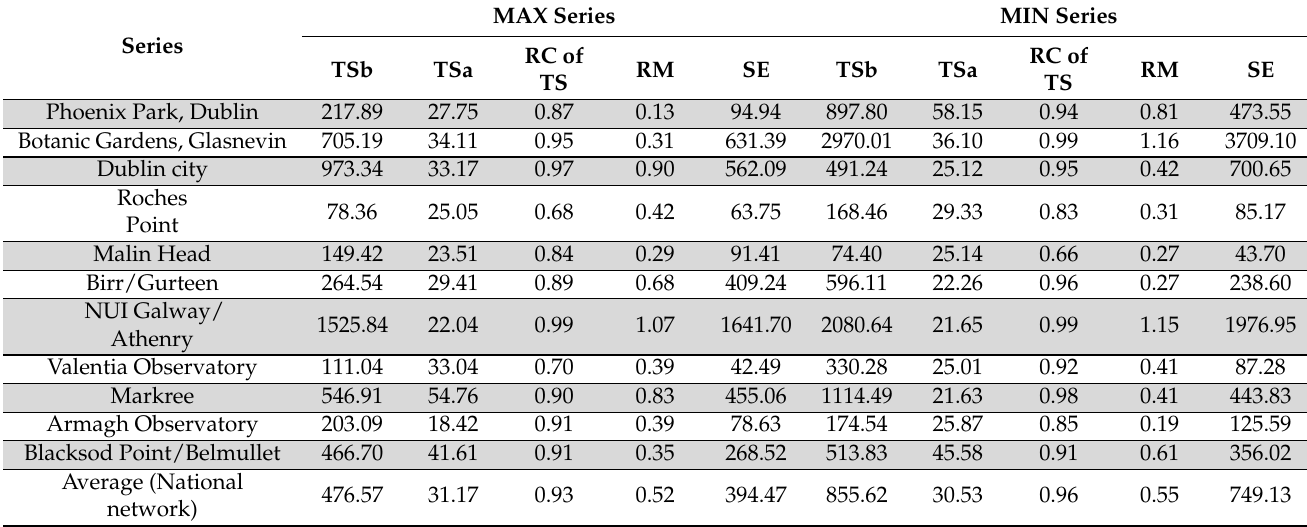
Table 7. Average test statistics for series included in the national network. Critical value (significance level 0.05): 21.94. TSb—test statistics before homogenisation; TSa—test statistics after homogenisation; RC of TS—relative change of TS; RM—relative modification; SE—statistics for estimated inhomogeneities.